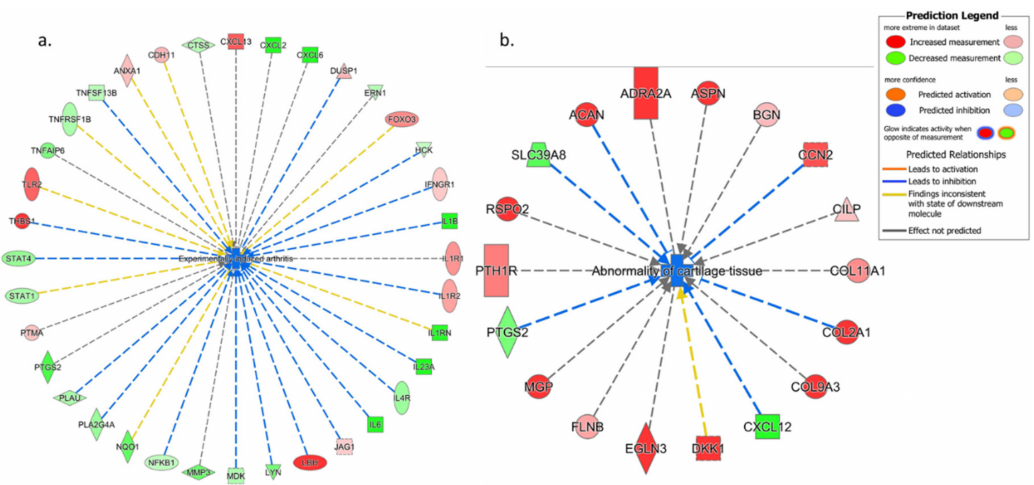
Figure 4. Ingenuity Pathways Analysis (IPA) showing top connective tissue disorders from the table of low-level (specific) process or functions. ( a ) Example network of the term “Experimentally induced arthritis” for VA vs. Ctr group, which was composed of mostly downregulated cytokines, chemokines, and nuclear factor kappa-light-chain-enhancer of activated B cells (NF- κ B) downregulation. ( b ) Example network of the term “Abnormality of cartilage tissue” for Epi C vs. Ctr group, which showed upregulation of collagens, biglycan, CCN2, and SOX9. Red represents upregulation of genes, while green represents downregulation of genes. Light red or green represent slight upregulation or